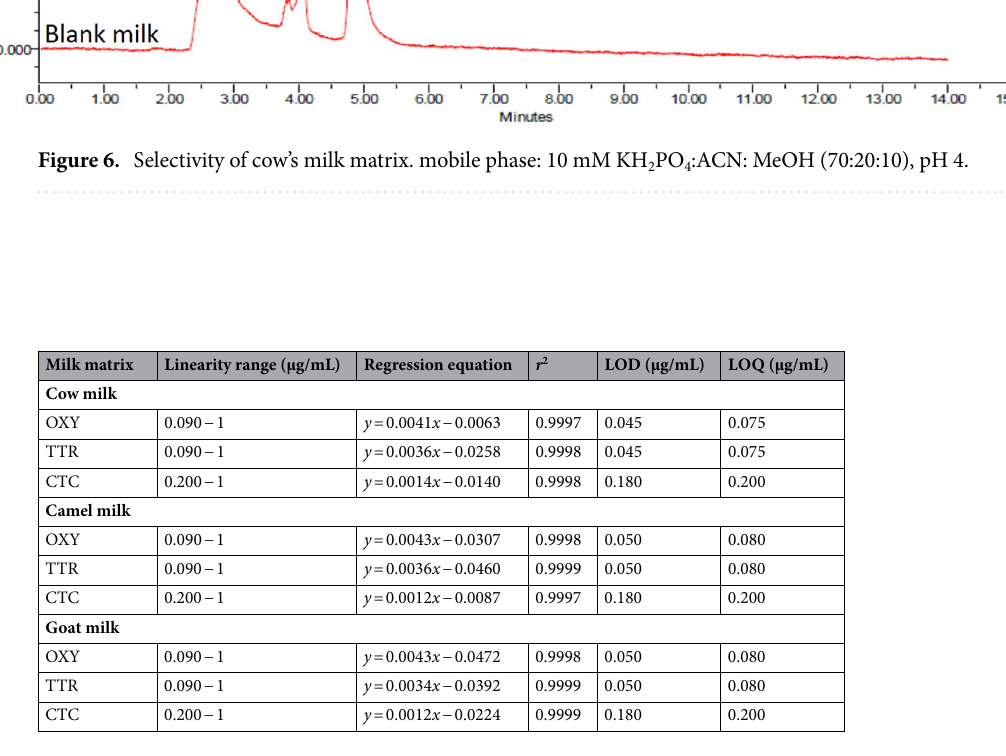
Table 4. Regression equations and LOD/LOQ for the milk